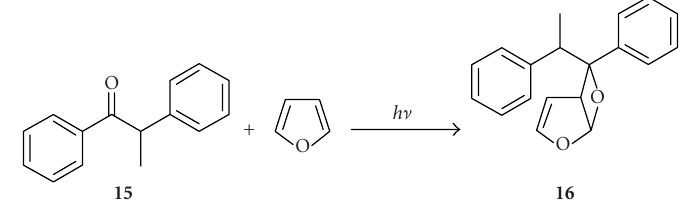
Figure 11: The photoaddition of rac 2-phenylpropiophenone to furan.